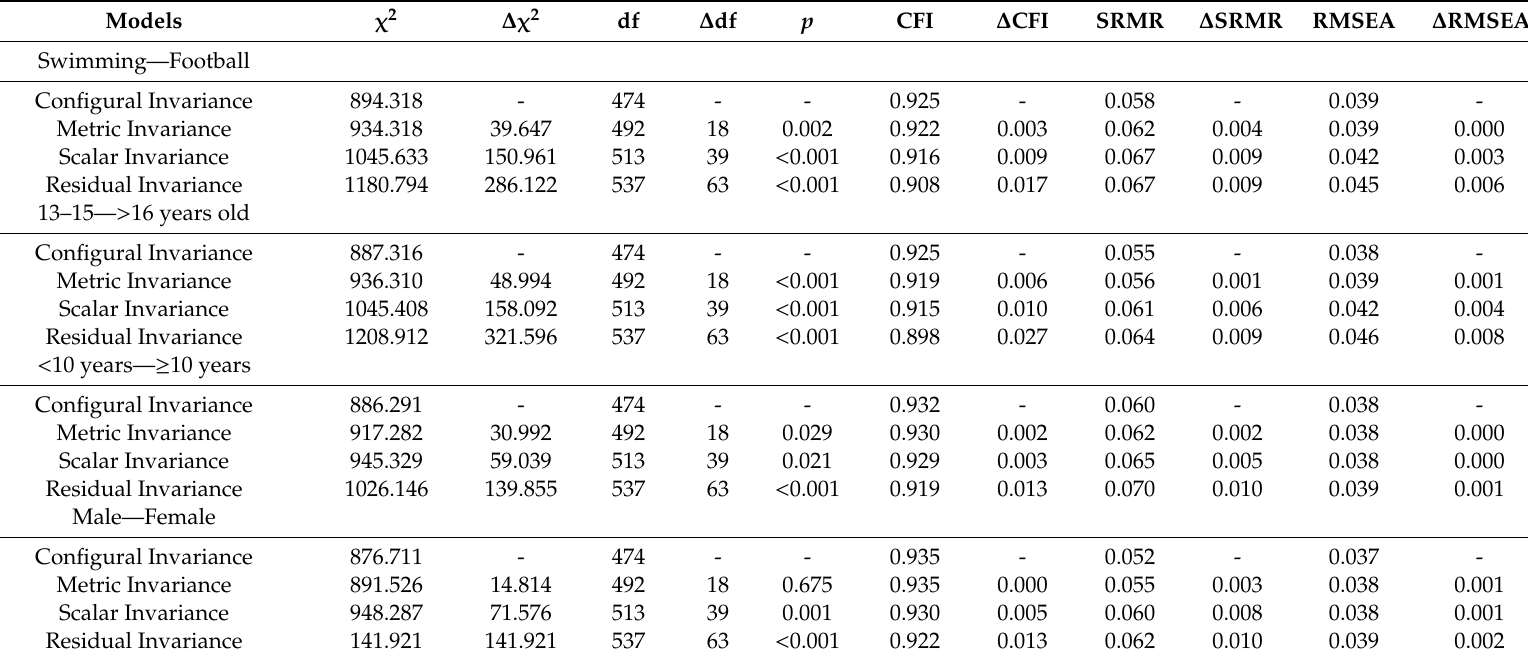
Table 5. Multigroup analysis